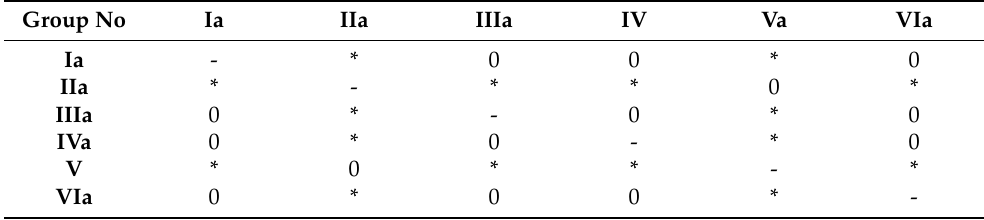
Table A9. The ratio of the capsule surface to the capillary tuft surface in rats fed with a high- cholesterol diet. Statistical differences between all experimental groups; * significant, 0